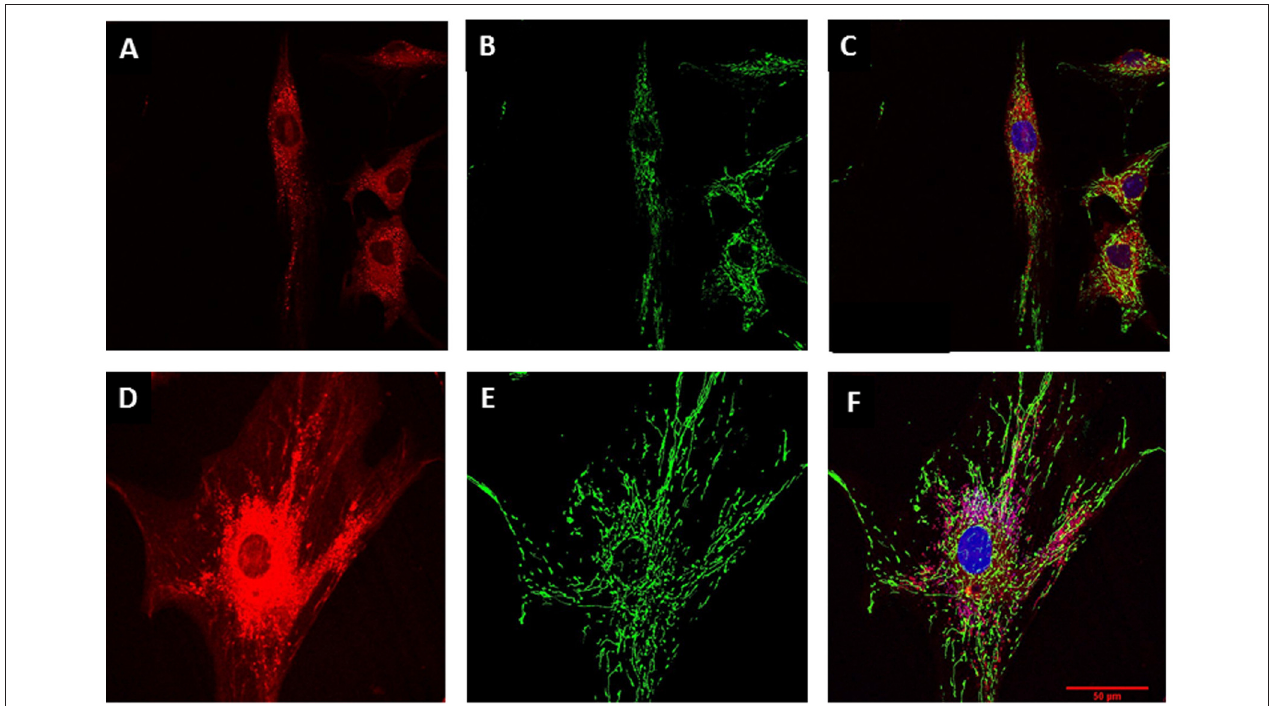
FIGURE 3 | Mitochondrial characterization. MSC cell morphology and mitochondrial mass evaluation by confocal microscopy. (A) MSC at PD2 cytoplasm revealed by CellTracker red. (B) Mitochondrial stain with Mito Tracker green for MSCs at PD2. (C) Merge for (A) and (C) with nucleus stained with Hoechst (blue). (D) Larger cytoplasm in MSC at PD7 revealed by CellTracker red. (E) Mitochondrial stain with Mito Tracker green for MSCs at PD7. (F) Merge for (A) and (C) with nucleus stained with Hoechst (blue). Scale bar 50 µ m for all